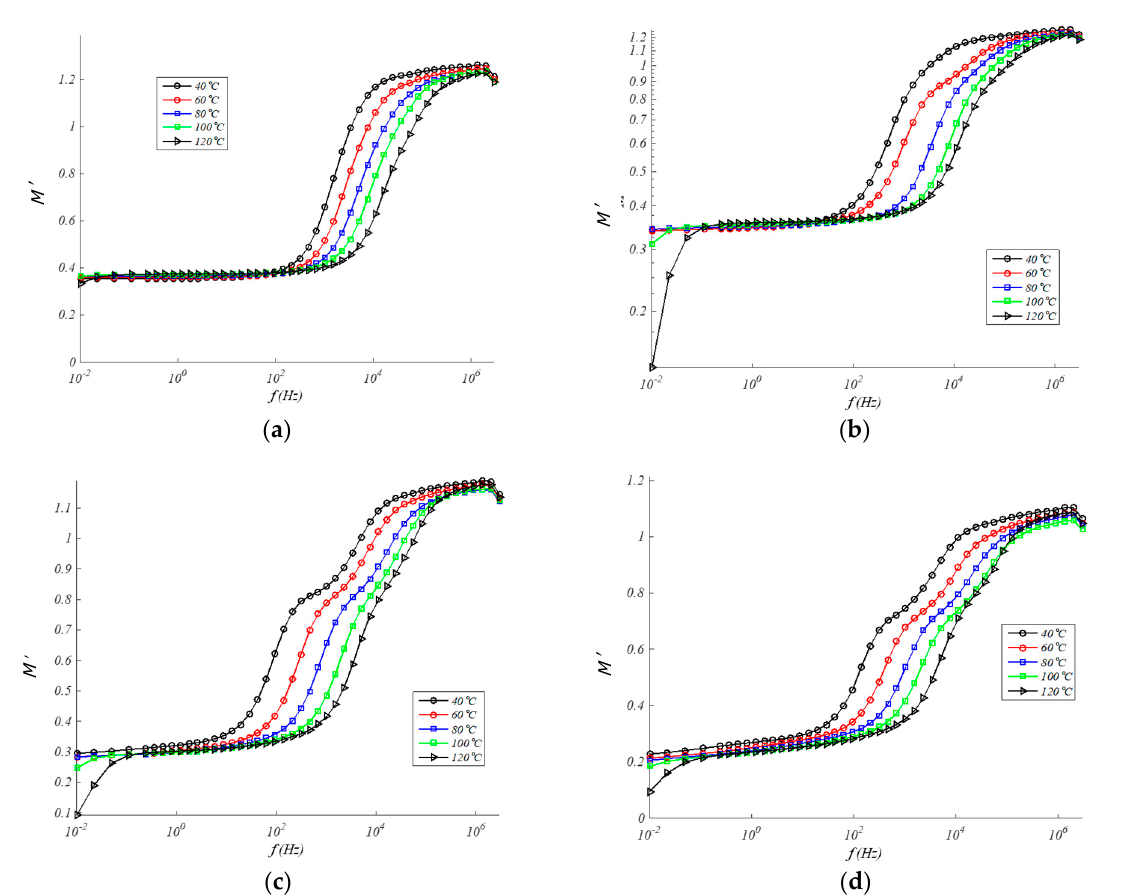
Figure 7. Real modulus in EPDM composites for: ( a ) 0% GTR or neat EPDM; ( b ) EPDM + 5% GTR; ( c ) EPDM + 10% GTR; ( d ) EPDM + 20% GTR.